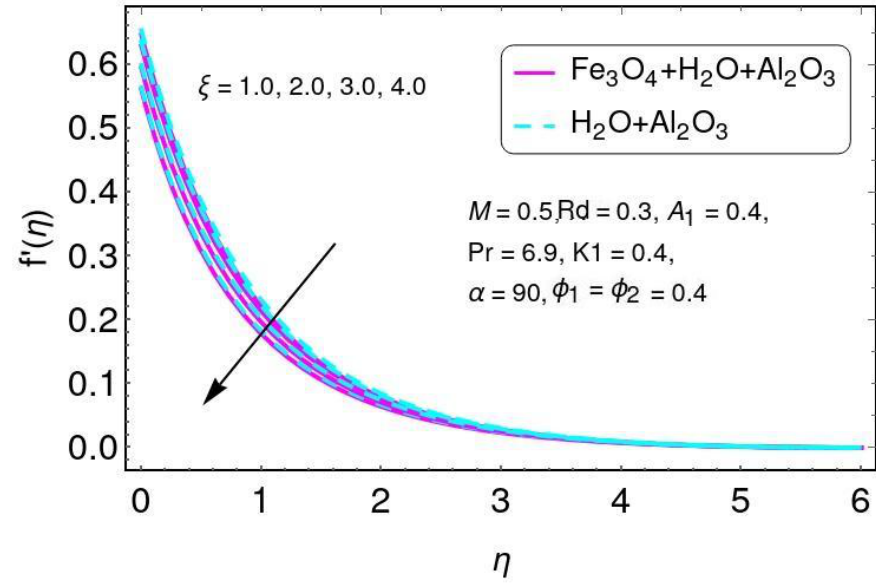
Figure 4. The distribution of f (cid:48) ( η ) for ξ .